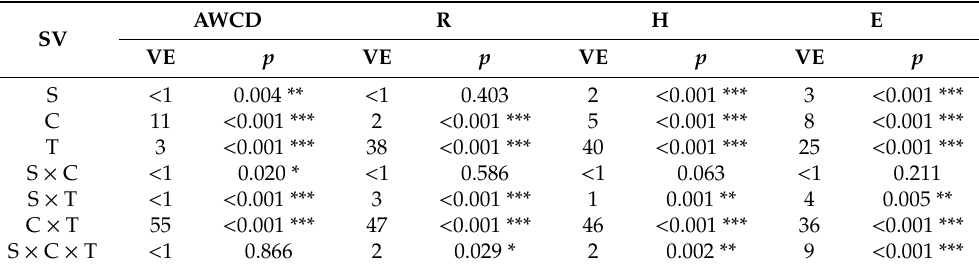
Figure 3. Effect of EM and/or strain MC3 on the values of the CLPP indices, i.e., AWCD ( A ), Rs ( B ), H ( C ) and E ( D ). The data presented are the means of three replicates with standard deviations. Significant differences (LSD test, p < 0.05) between treatments at the same sampling time and between sampling times within the same treatments are denoted with different lower and uppercase letters, respectively. The treatment abbreviations are explained in Figure 2. Table 1. Results of the three-way ANOVA for the CLPP indices.